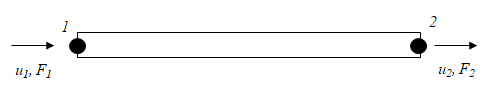
Figure 2. Two nodes elementary and Love